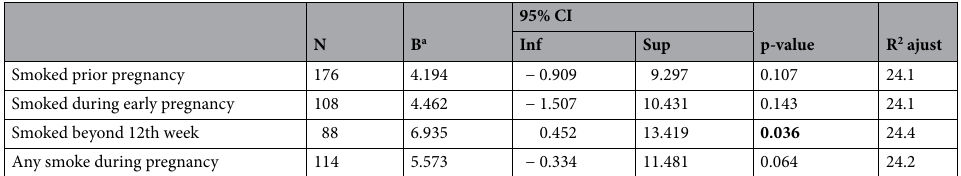
Table 4. Effect of maternal smoking on offspring systolic blood pressure percentile at 11 years by assessing maternal smoking in different stages of gestation. Sample size 542 patients because of missing data. Significant values are in bold. a Coefficient in the linear regression model to predict SBP percentile at 11 years of age (percentile unit) adjusted by country, mother’s educational level, mother, and father’s BMI before pregnancy, feeding type, ponderal index at birth, and BMI z-score at 11